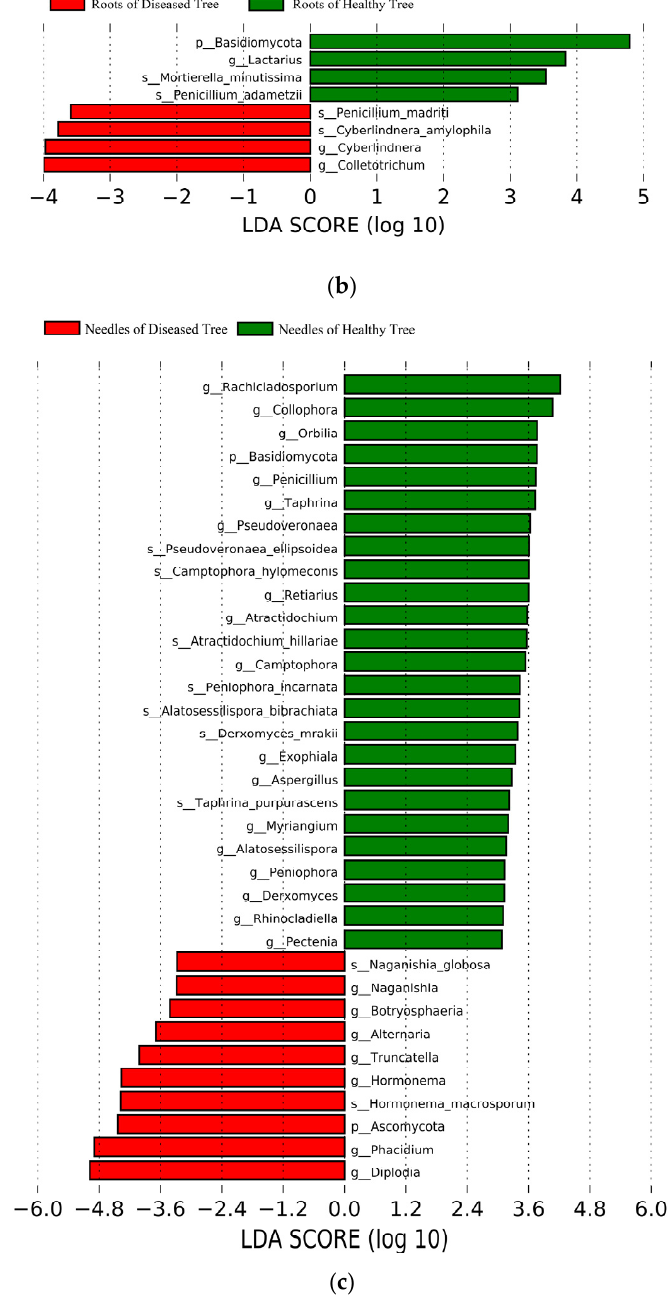
Figure 5. Linear discriminant analysis (LDA) effect size (LEfSe) showing fungal phyla, genera, and species that significantly differed in ( a ) soil, ( b ) roots, and ( c ) needles around and of healthy and diseased trees. Abbreviations: p, phylum; g, genus; s,